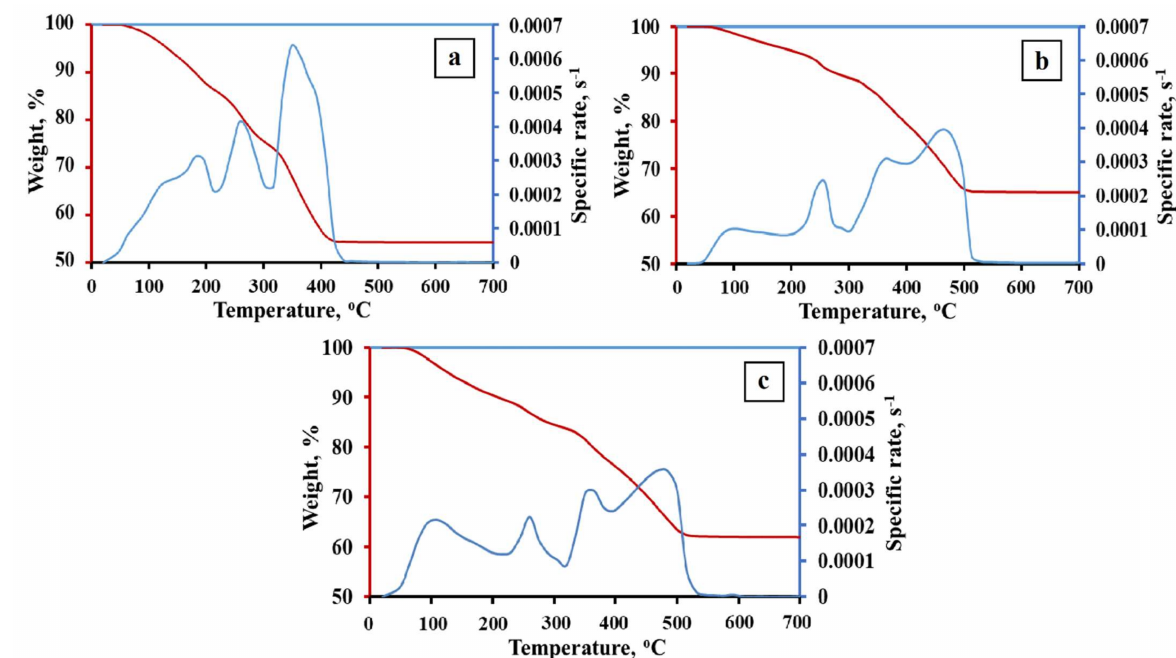
Figure 2. Thermal gravimetric (TG) kinetic curves of the Fe–Co–Ni hydroxides. ( a ) 1Fe–Co–Ni, ( b ) 3Fe–Co–Ni, ( c ) 5Fe–Co– Ni, ( dm/d τ )/ m 0 is the specific rate; m 0 is the initial weight.